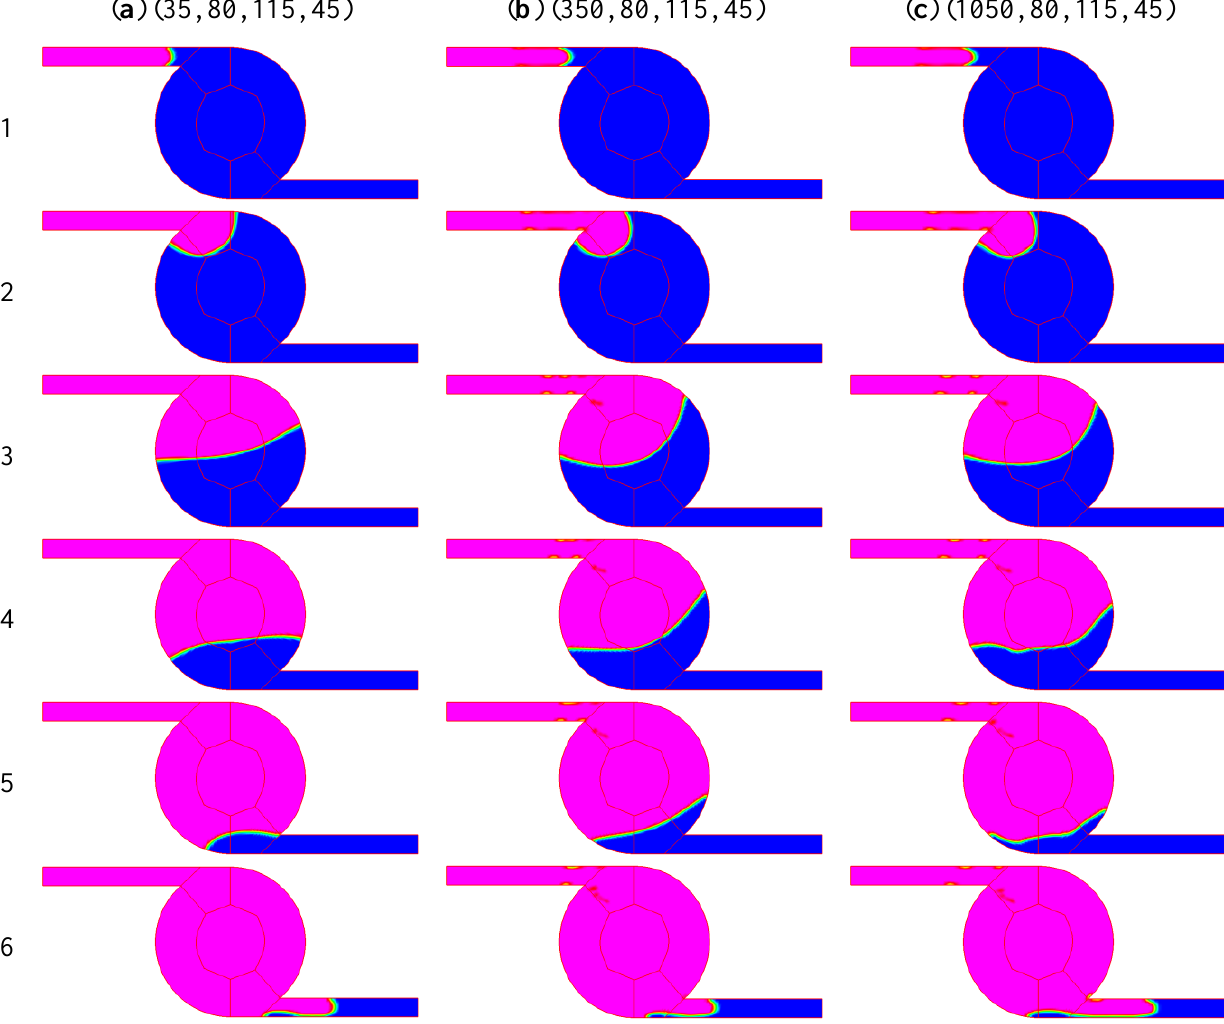
Figure 10. Filling process for various K . ( a ) K is 35° s/m, θ ( b ) K is 350° s/m, θ 45° and θ